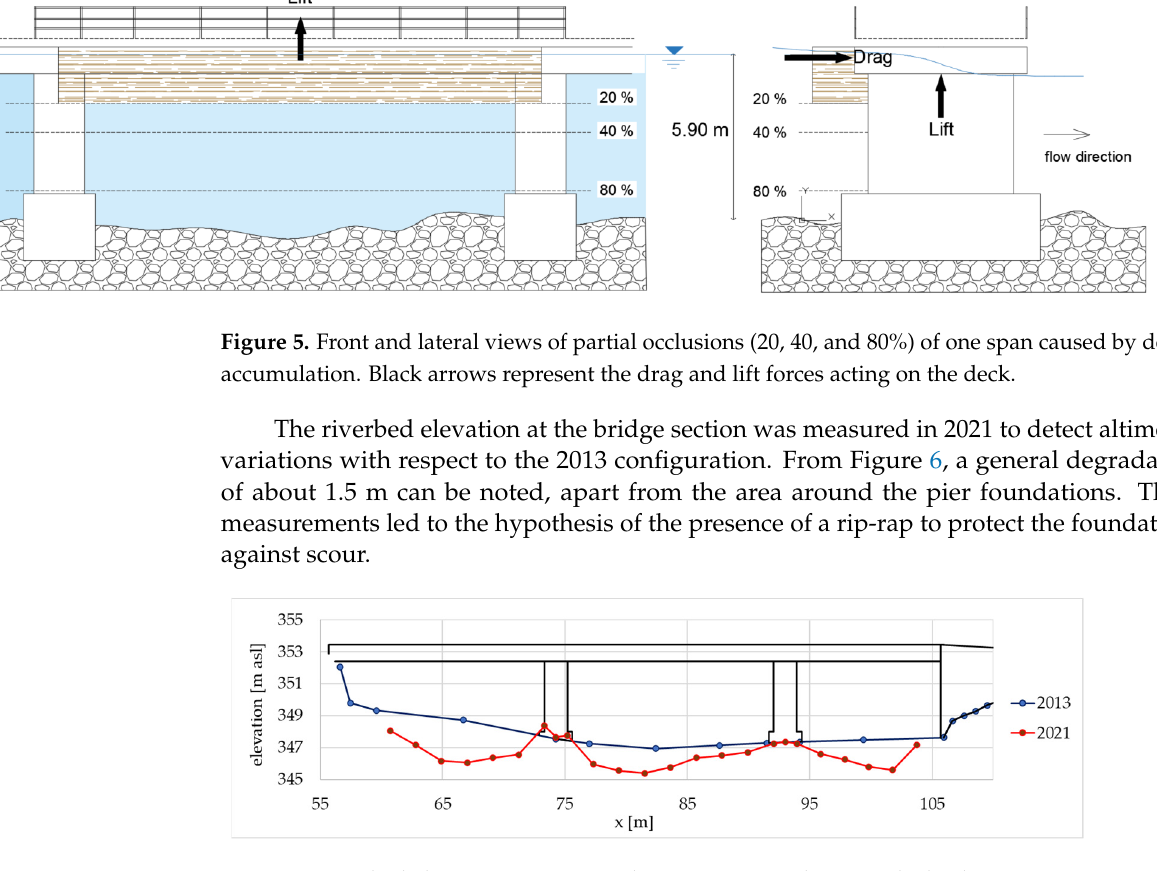
Figure 6. Riverbed elevation comparison between 2013 and 2021 at the bridge cross-section.